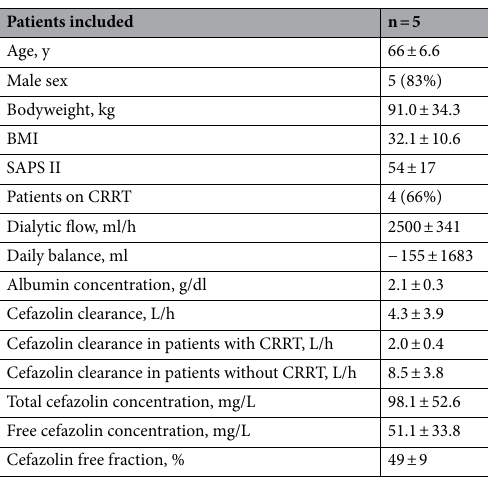
Table 1. Patient and clinical characteristics. Data are given as mean + / − s.d. or count and percentage as indicated. Y years, kg kilogram, BMI body mass index, SAPS II Simplified Acute Physiology Score II, CRRT continuous renal replacement therapy, ml milliliter, h hour, g gram, dl deciliter, L liter, % = percentage.